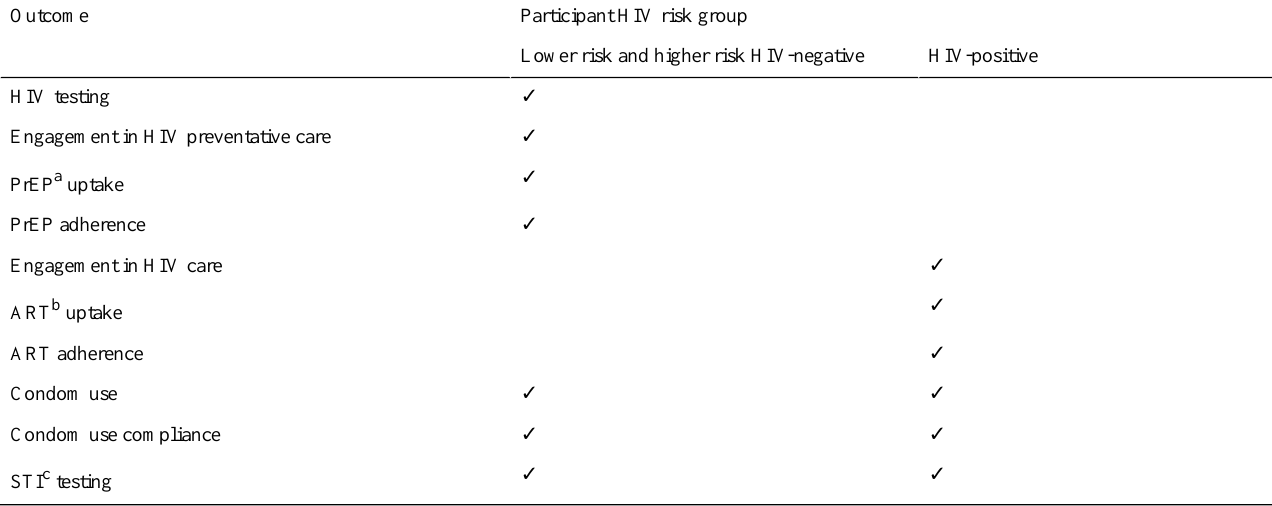
Table 2. Primary